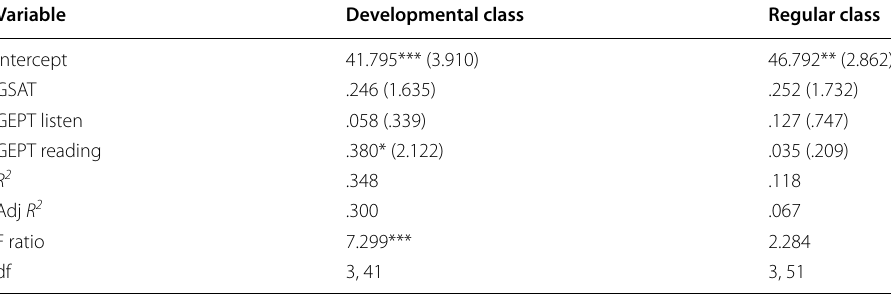
Table 9 Regressions for the predictors across classes